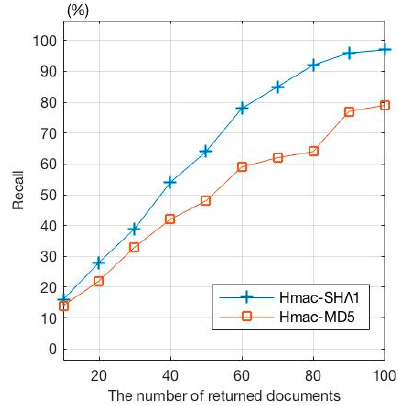
Figure 10. Evaluation of recall rate of search results.